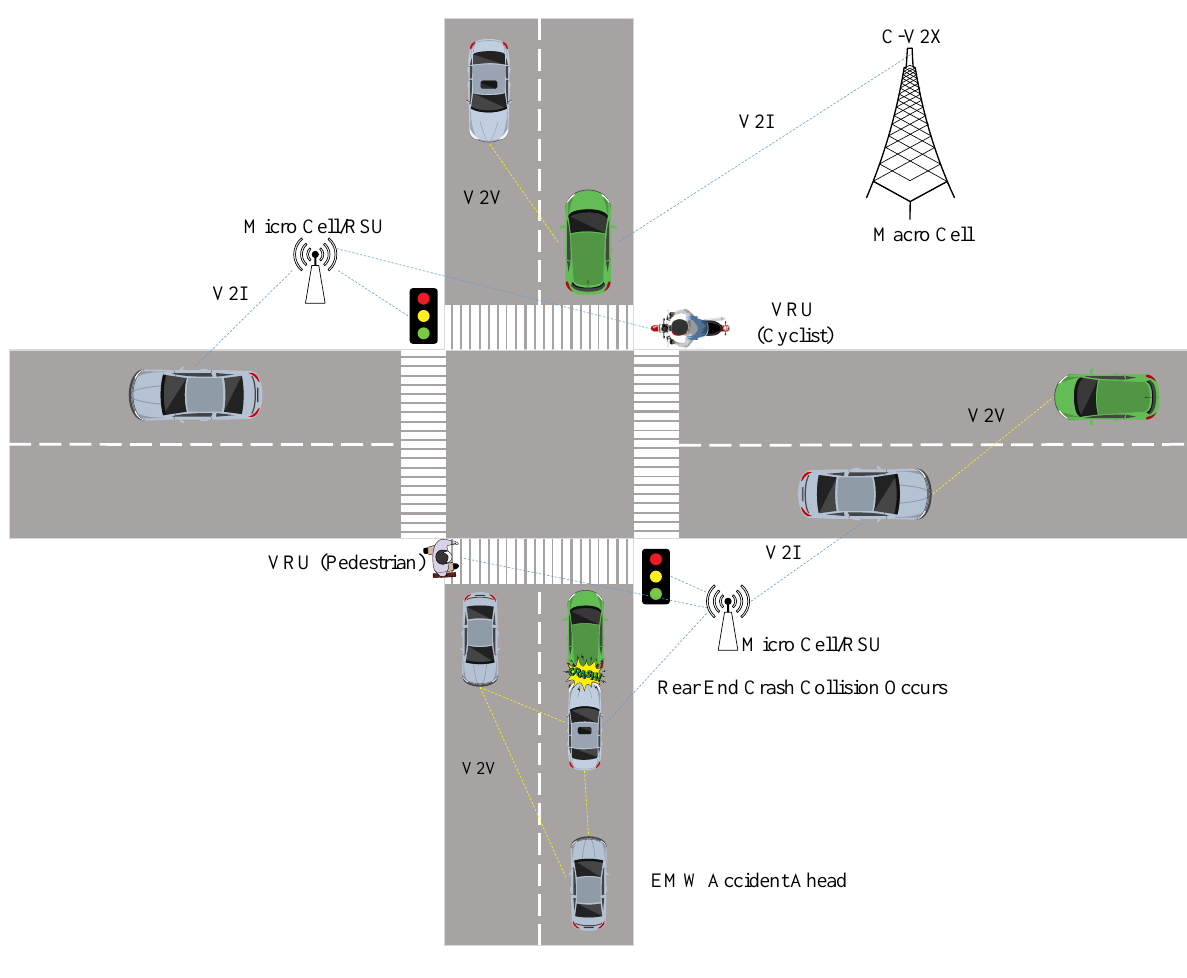
Figure 3. Post-crash safety warning